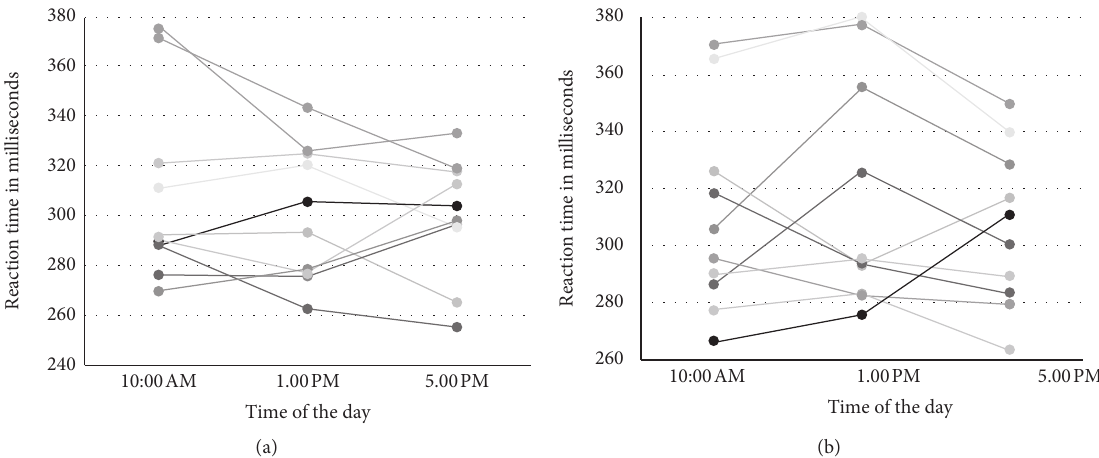
Figure 3: Changes in the visual simple reaction time of study participants (shown using different color lines) at different times of the day in (a) male participants and (b) female